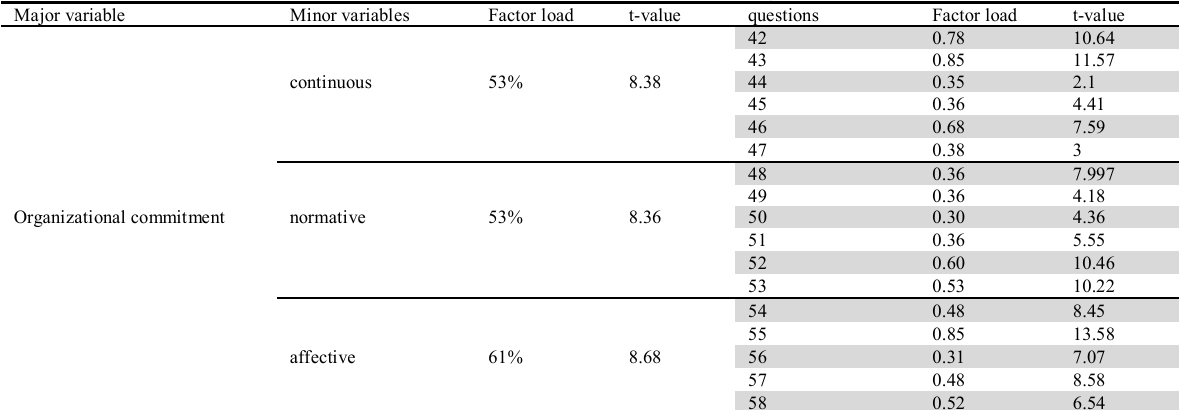
The standard factor load, meaningful statistics (t-value) scale of organizational commitment Major